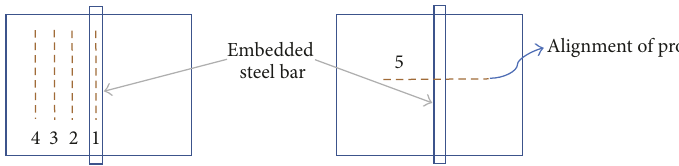
Figure 4: Five Wenner probe configurations with respect to embedded rebar tested by Sengul and Gjorv [8].